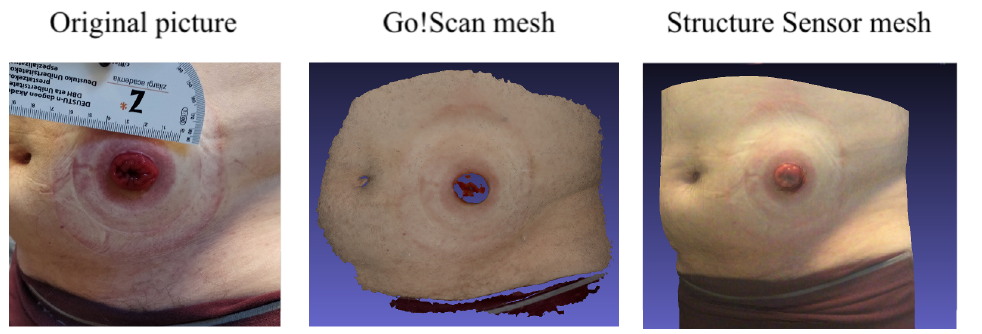
Figure 23. ( Left ): Original picture of the ostomy. ( Middle ): The mesh acquired using the Go!Scan. ( Right ): The mesh acquired using the Structure